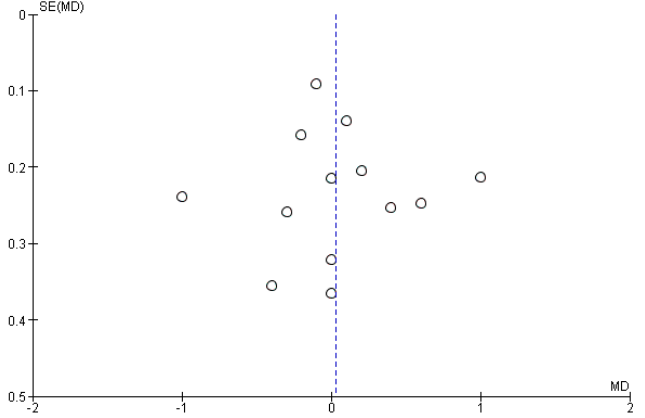
Figure 5. Funnel plot of studies evaluating the administration of probiotic and weeks of gestation.